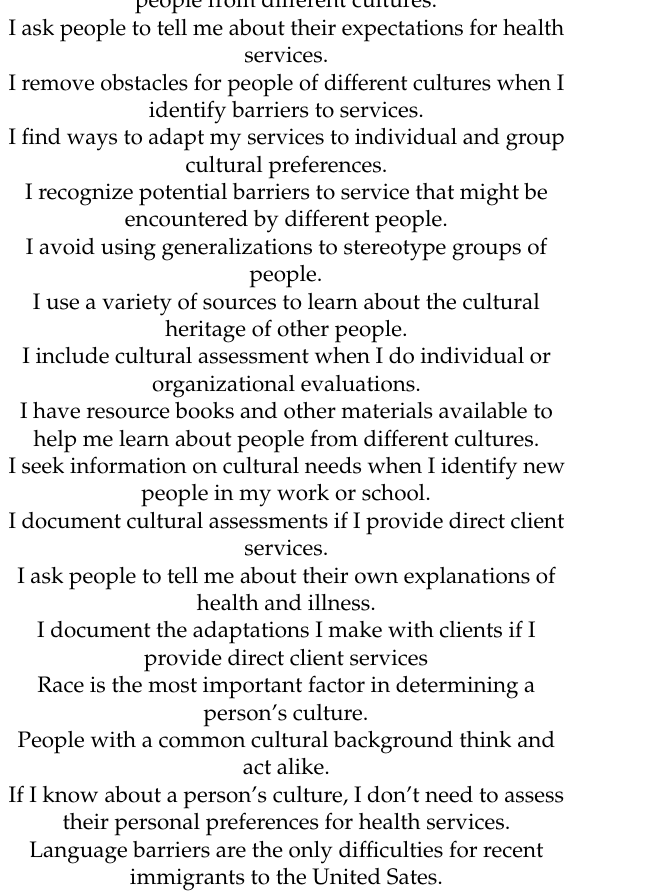
Seeking Cultural Active Behavior Information Awareness